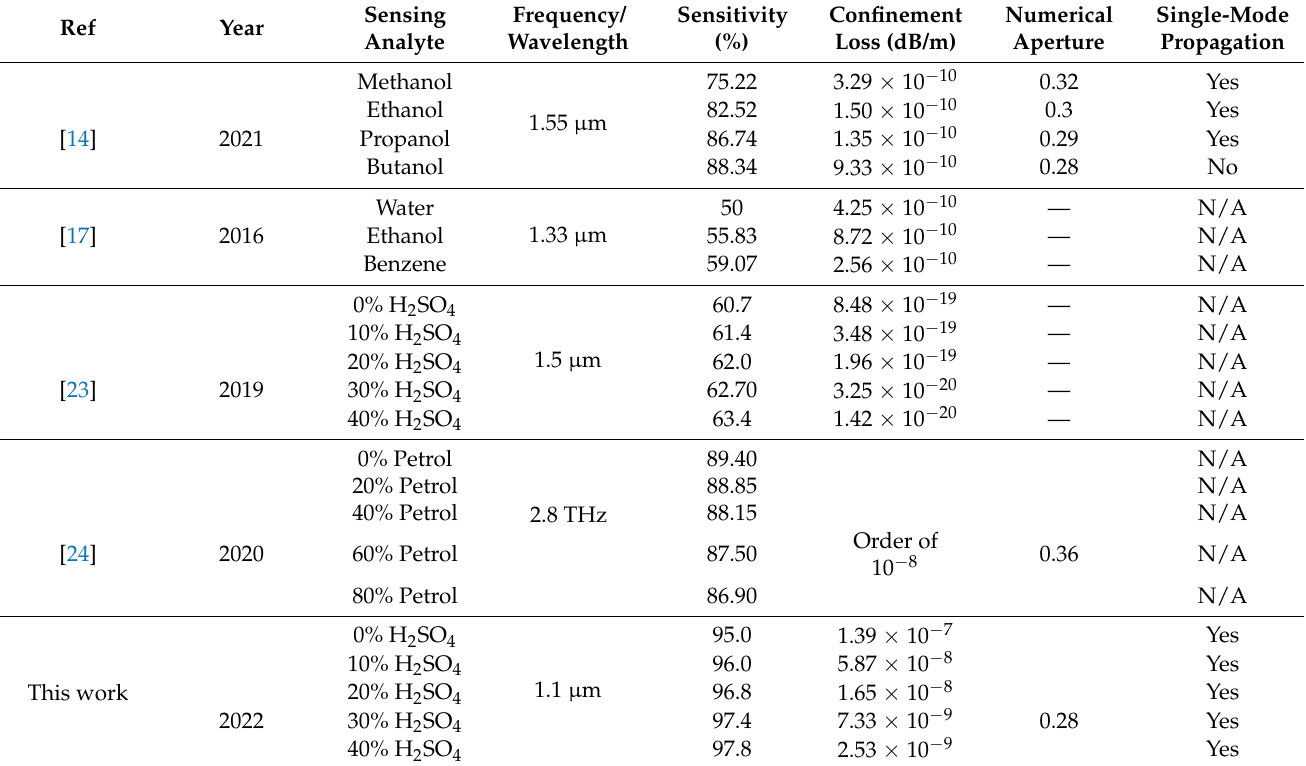
Table 2. Comparison between the guiding and sensing properties of some of the recently proposed schemes.